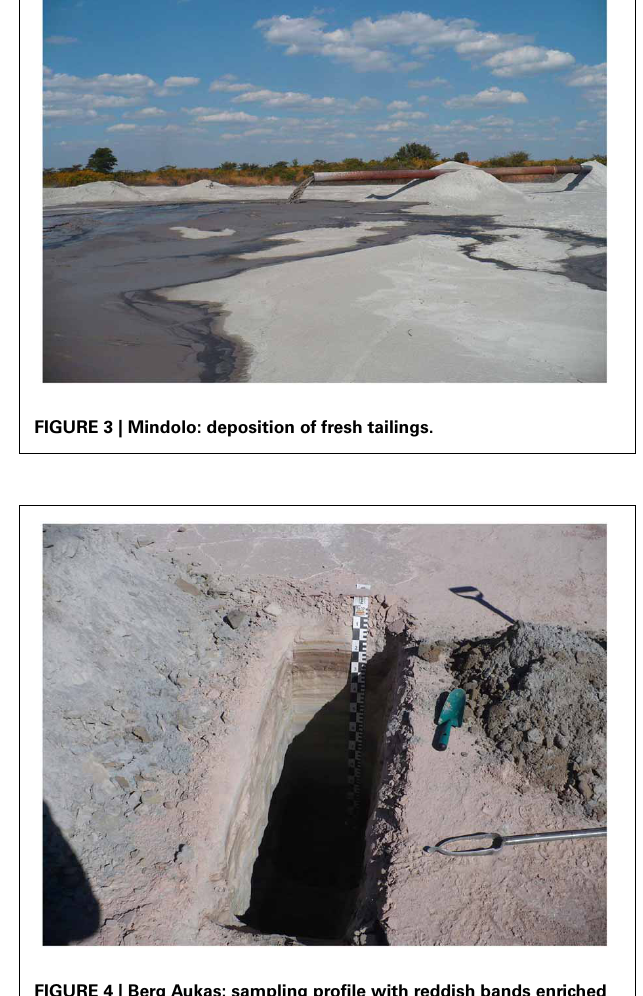
FIGURE 4 | Berg Aukas: sampling profile with reddish bands enriched in iron. FIGURE 5 | Kombat: central plateau of mine